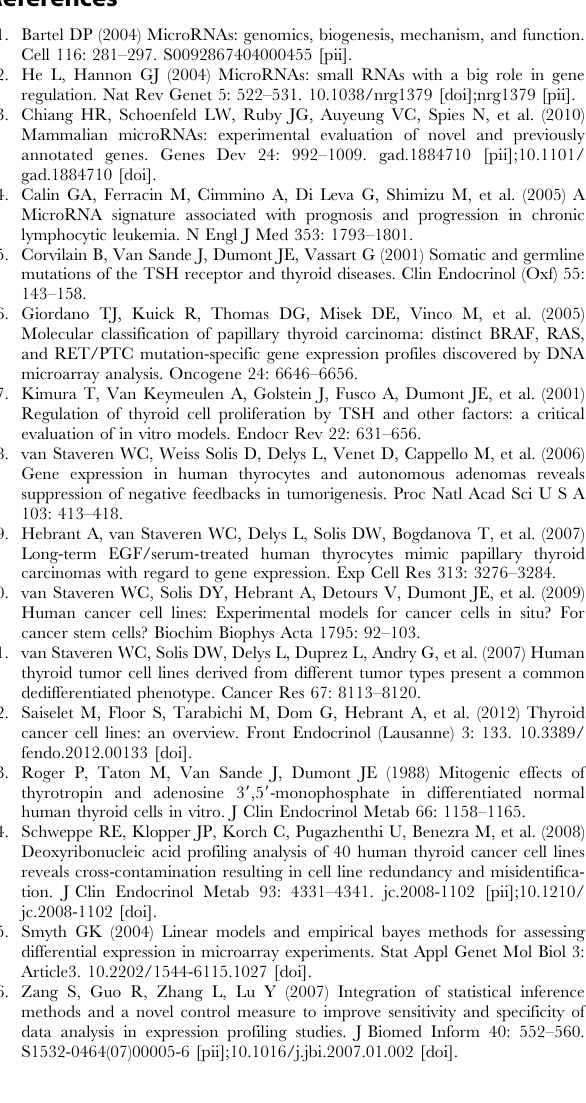
Figure S2 Validation of the miRNA microarray